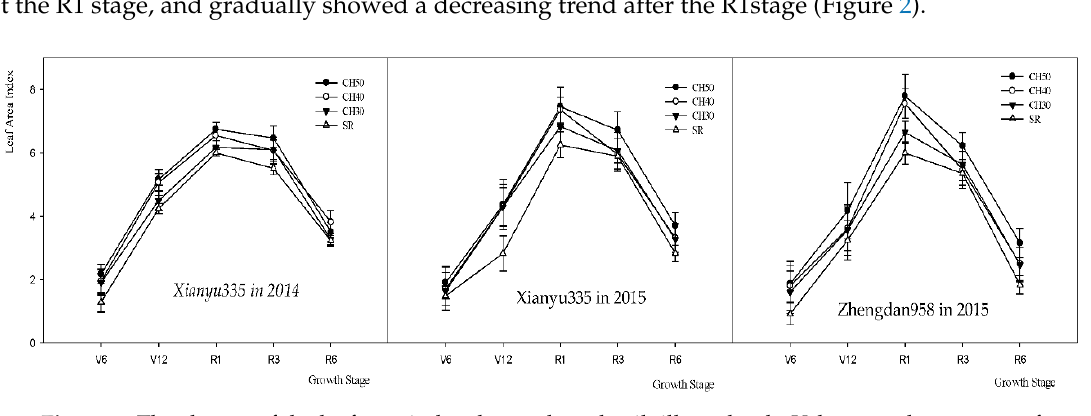
Figure 2. The change of the leaf area index due to the subsoil tillage depth. Values are the average of three replications. Bars indicate ±1 standard error of the mean.